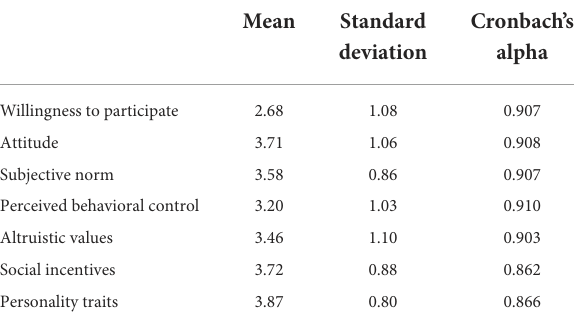
TABLE 2 Mean variable values and reliability